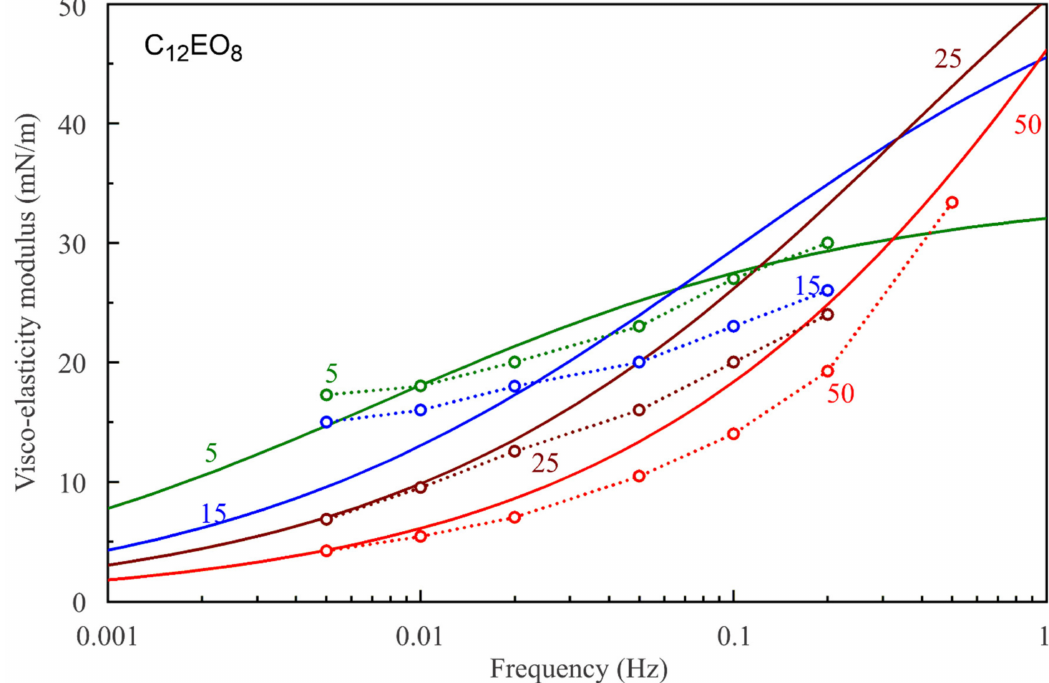
Figure 10. Experimental visco-elasticity modulus vs. frequency for C 12 EO 8 solutions of different concentrations (5, 15, 25, and 50 µ mol/L, as indicated by numbers) and the respective theoretical curves calculated with the LvT equation, Equation (8), with E 0 (c) and ω D (c) calculated by using the reorientation model, Equations (1)–(6), with the parameter sets presented in Table 1. Dotted lines are guides for the